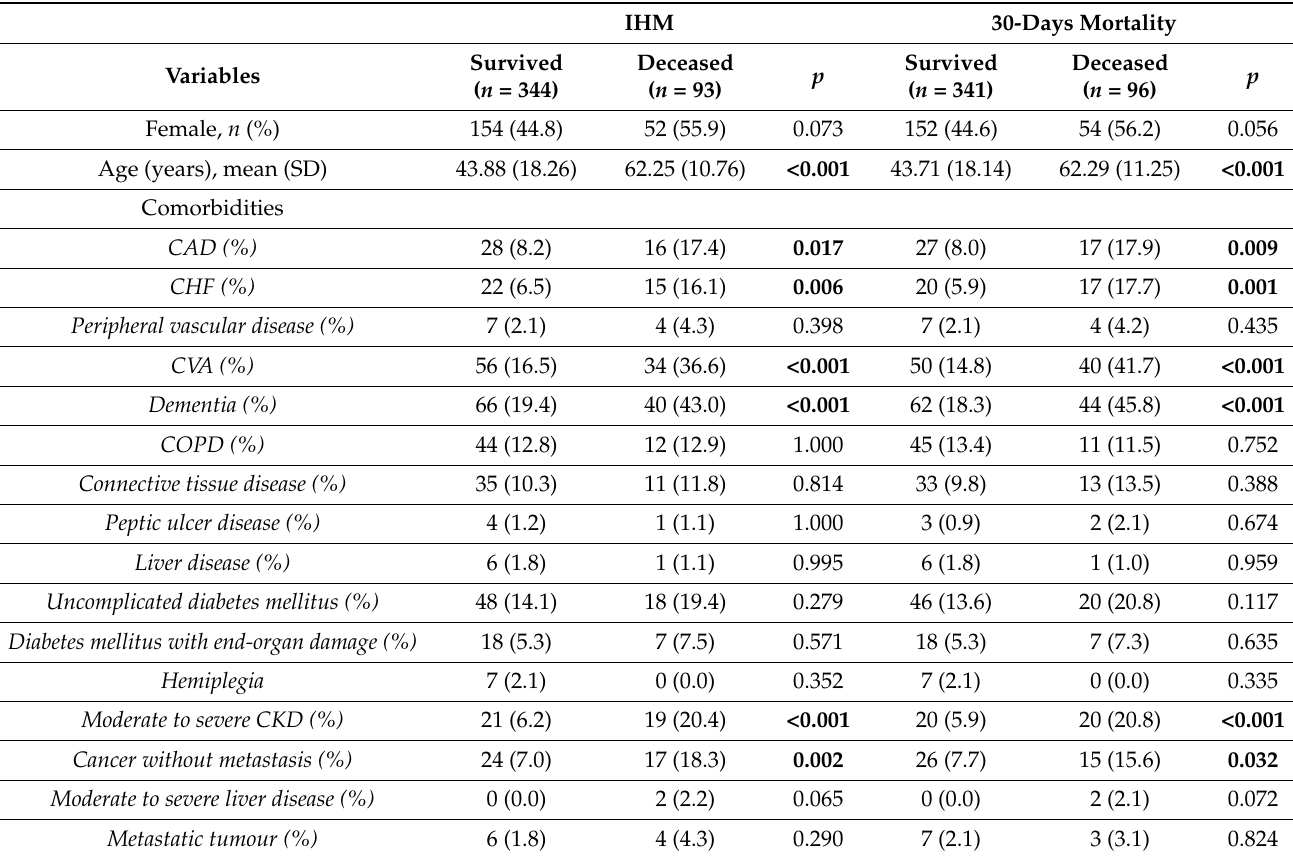
Table 3. Characteristics of enrolled participants according to IHM and 30-day